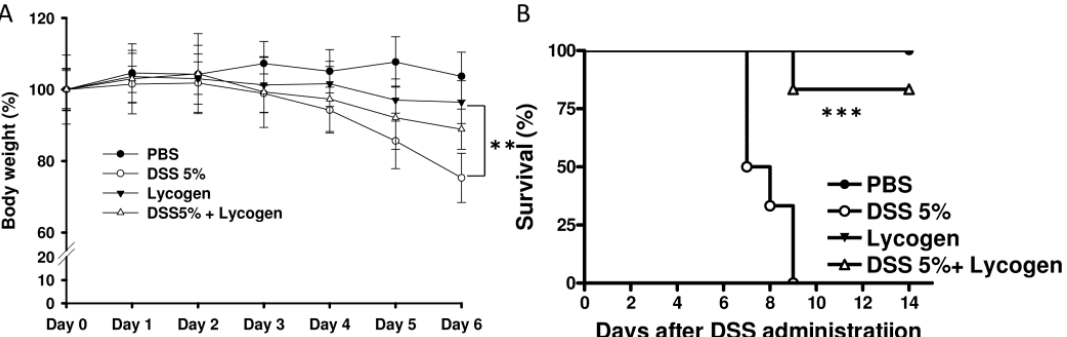
Figure 2. Effect of Lycogen™ on DSS-induced colitis mice. ( A ) The mice with colitis were orally administered with Lycogen™ (1 mg/kg) for six consecutive days after DSS induction and the body weights of mice were determined (means ± SD, n = 6). p < 0.01 for colitis mice treated with Lycogen™ versus colitis mice treated with PBS ( B ) Kaplan-Meier survival curves on day 14 are shown. (mean ± SD, n = 6) Significance of differences between groups for continuous variables was assessed using the Student t-test. The mice survival analysis was performed using the Kaplan-Meier survival curve and log-rank test. ** p < 0.01; *** p <